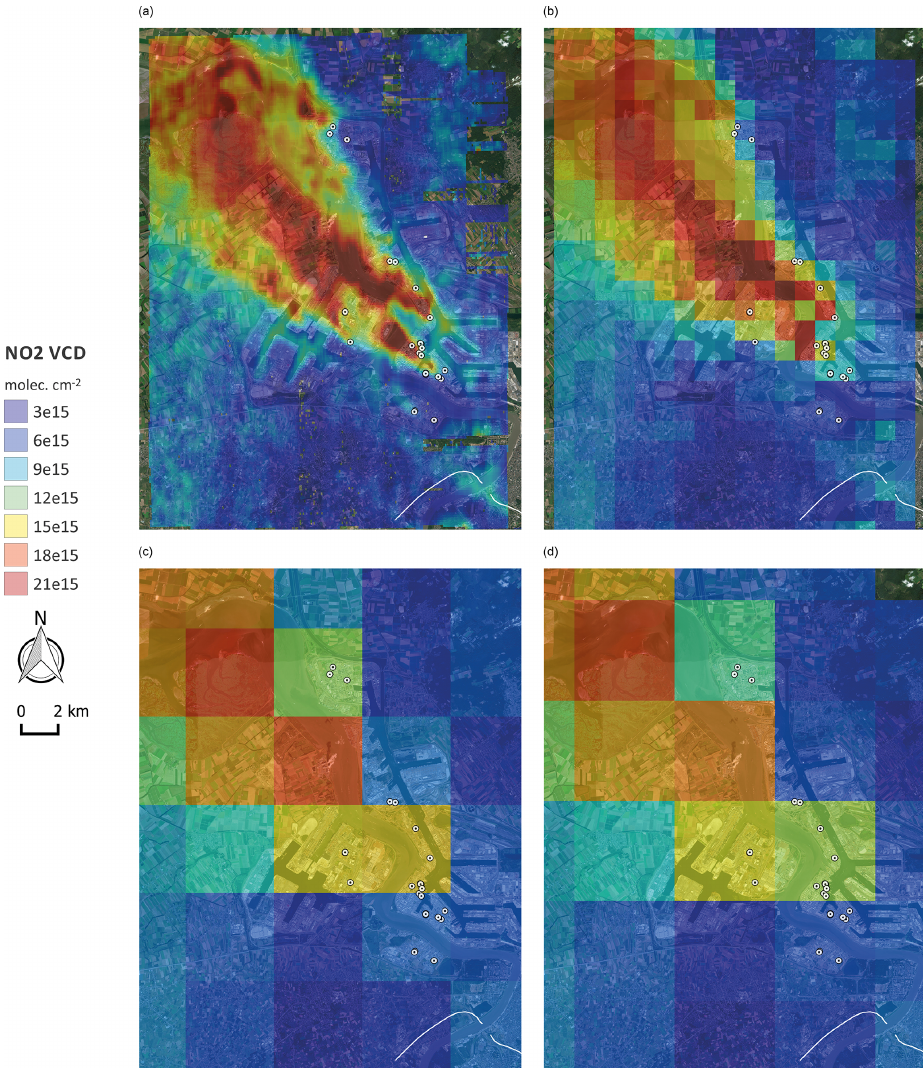
Figure 13. (a) APEX NO 2 VCD grid retrieved over Antwerp on 29 June, at 0.1km × 0.1km resolution, and the computed pseudo-satellite NO 2 VCDs grids at (b) 1km × 1km, (c) 4.4km × 4.4km, and (d) 5km × 5km, respectively. White dots indicate the point sources, emitting more than 10kg of NO x per hour, according to the emission inventory (2017) of the Belgian Interregional Environment Agency. Part of the city ring road is indicated by the white line (© Google